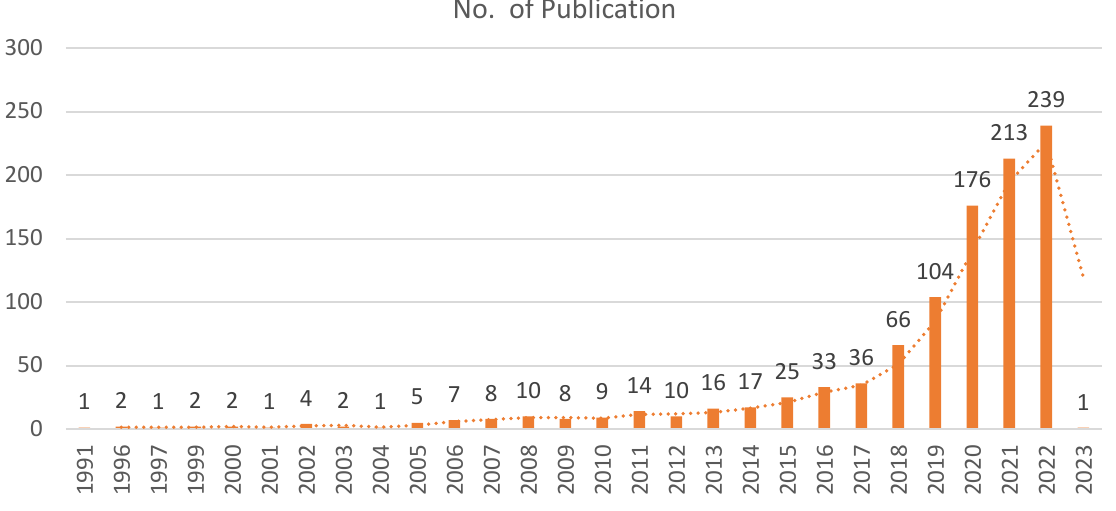
Figure 1. Annual volume of digital tourism studies